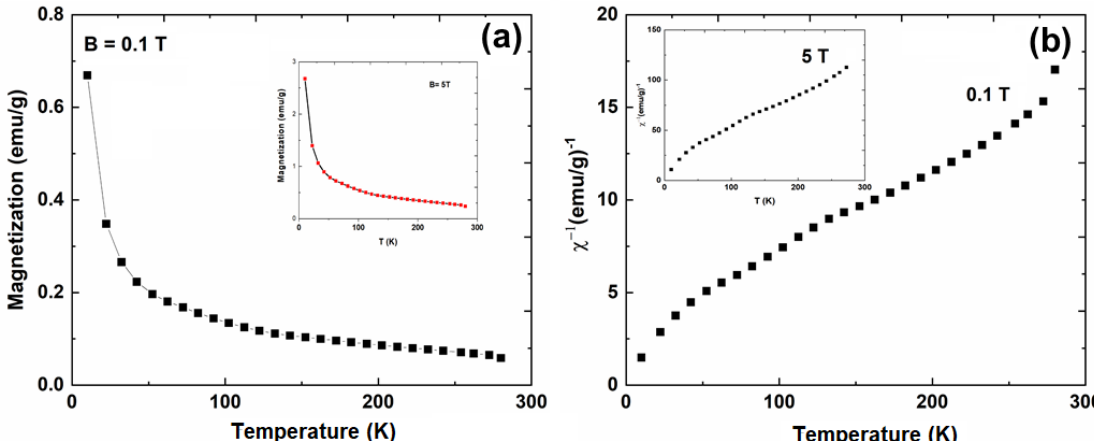
Figure 6. Temperature dependencies of the magnetization at an applied magnetic field of 5 T (inset) and 0.1 T, respectively, ( a ) and the inverse magnetic susceptibility at a perpendicularly applied magnetic field of 5 T (in inset) and 0.1 T, respectively ( b ).